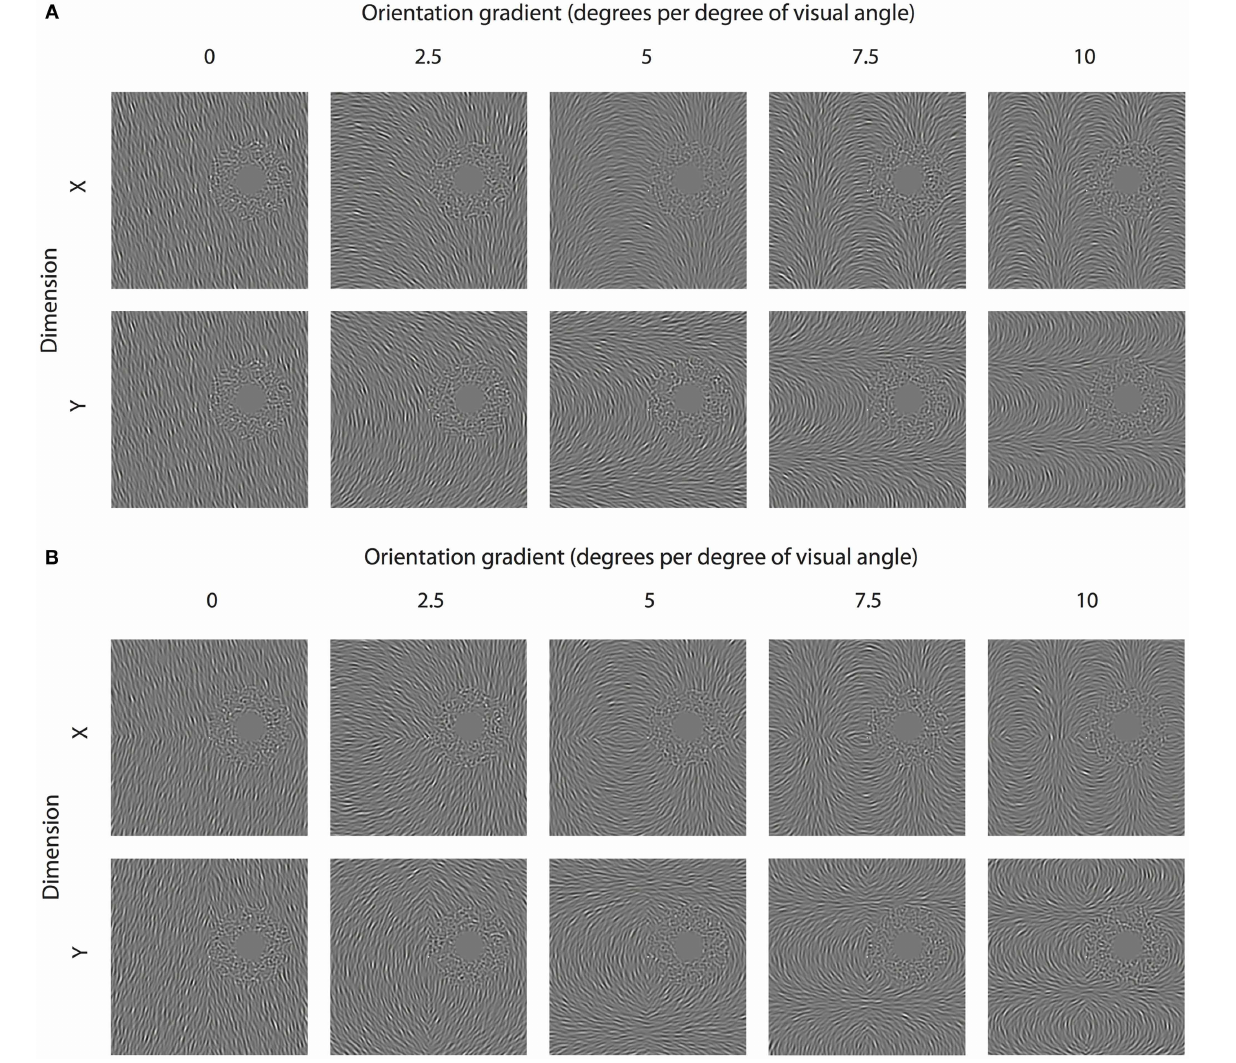
annulus), ensuring that the implied orientation at that position is constant (15 ◦ counter-clockwise of vertical). (B) Orientation textures containing reflectional symmetry. Textures with linear orientation gradients along the x and y axes contain symmetry about the horizontal and vertical meridians,